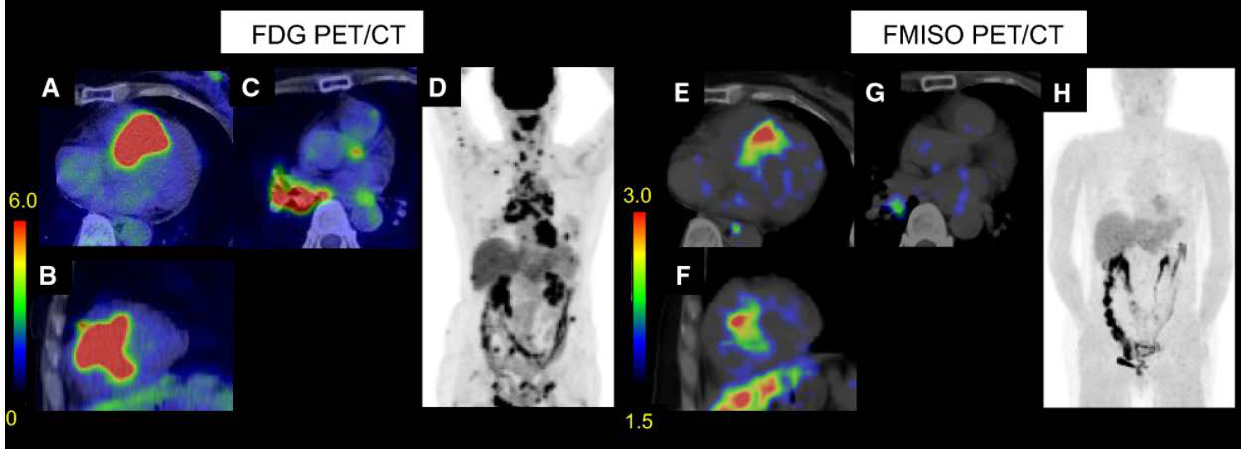
Figure 6. Example of 18 F-FDG PET/CT and 18 F-FMISO PET/CT images in a patient with cardiac sarcoidosis. Transverse, short-axis, and maximum intensity projection (MIP) images are provided. Significant abnormal cardiac 18 F-FDG uptake was seen, as well as abnormal uptake in lymph nodes in the neck, mediastinum, hilum, abdomen, and inguinal lymph nodes ( A – D ). 18 F-FMISO showed corresponding abnormal cardiac uptake, as well as abnormal uptake in a right hilar lymph node ( E – H ). Accessed on 11 July 2021. Modified and reprinted with permission from ref. [86]. Copyright 2021 Furuya, S. et al.